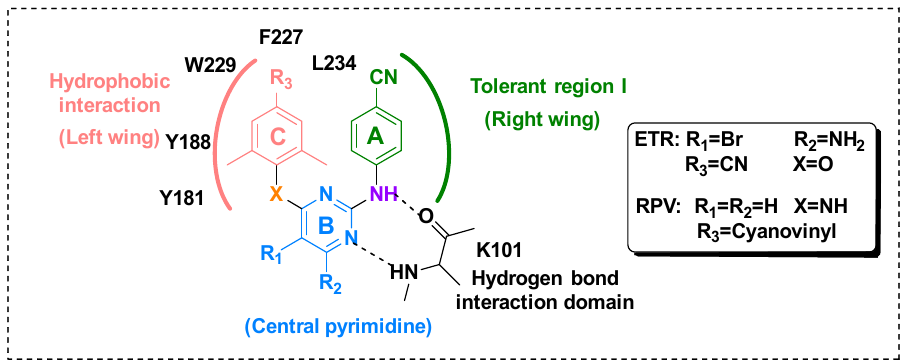
Figure 2. Illustration of the pharmacophore model of diarylpyrimidines.